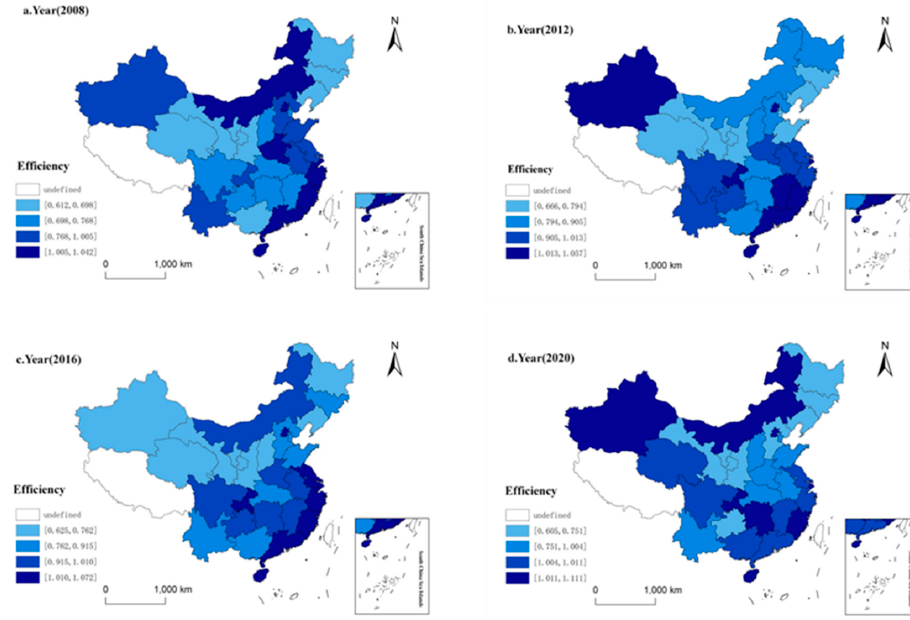
Figure 2. The spatial evolution pattern of efficiency of ESDE in China. Data source: Table 2.